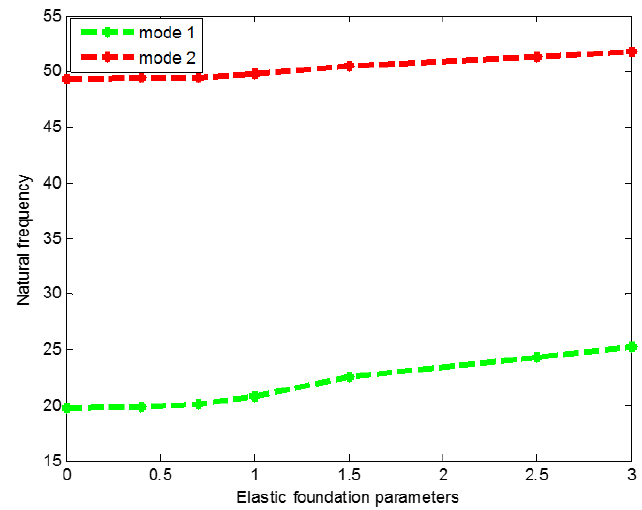
Figure 7. Variation of elastic foundation parameter on SS-edge condition